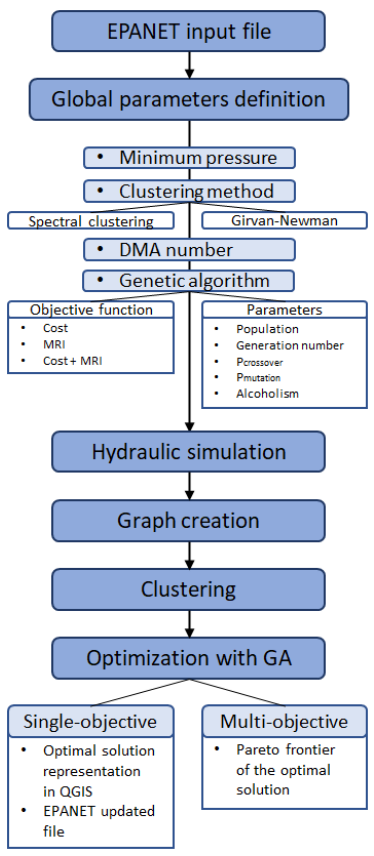
Figure 1. Python code flow chart.